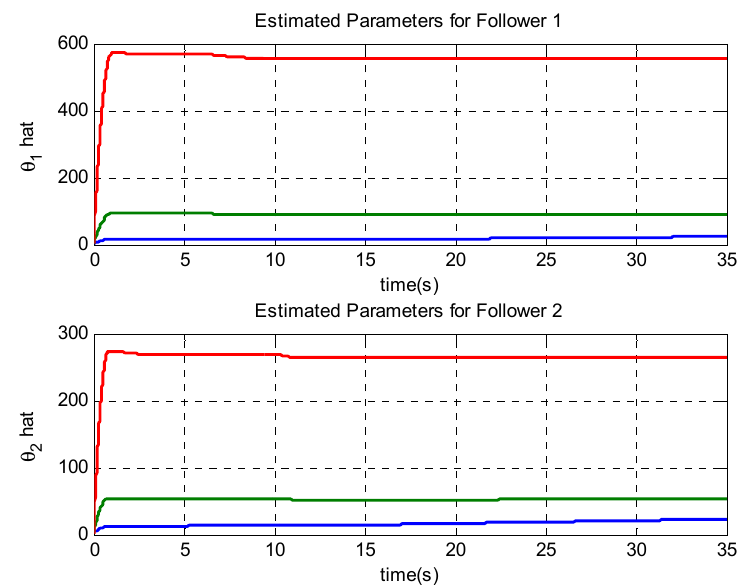
Figure 9. Estimated value of the vector ˆ θ i